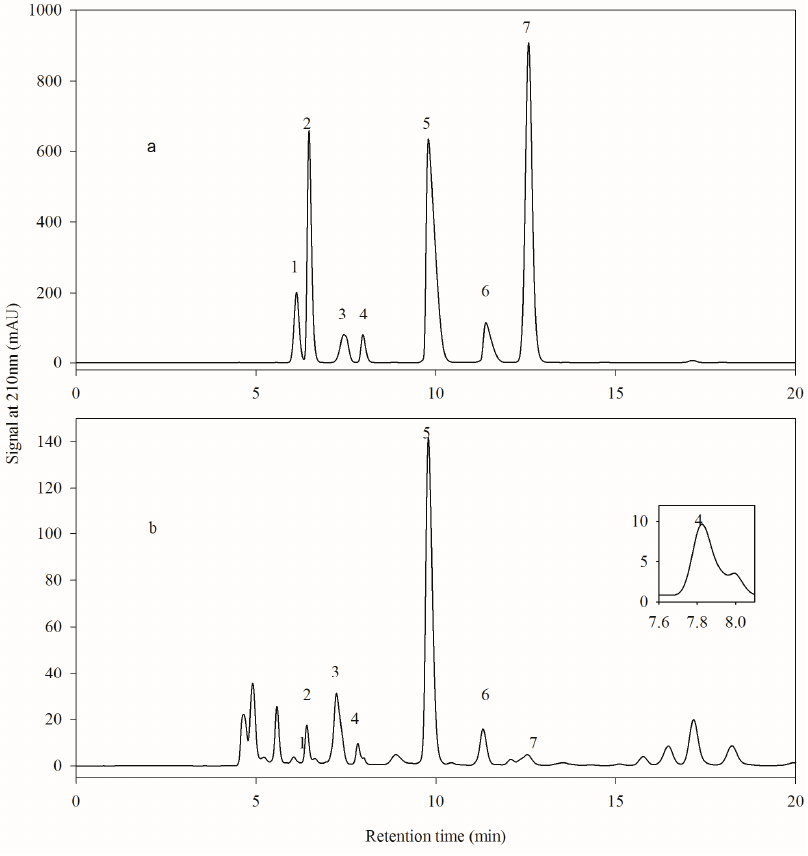
Figure 2. Analysis of organic acids with HPLC method 2. ( a ) Chromatogram of organic acid standards; ( b ) Chromatogram of the hawthorn wine. Peak 1, 2, 3, 4, 5, 6 and 7 were pyruvic acid, l -malic acid, lactic acid, acetic acid, citric acid, succinic acid, and fumaric acid.